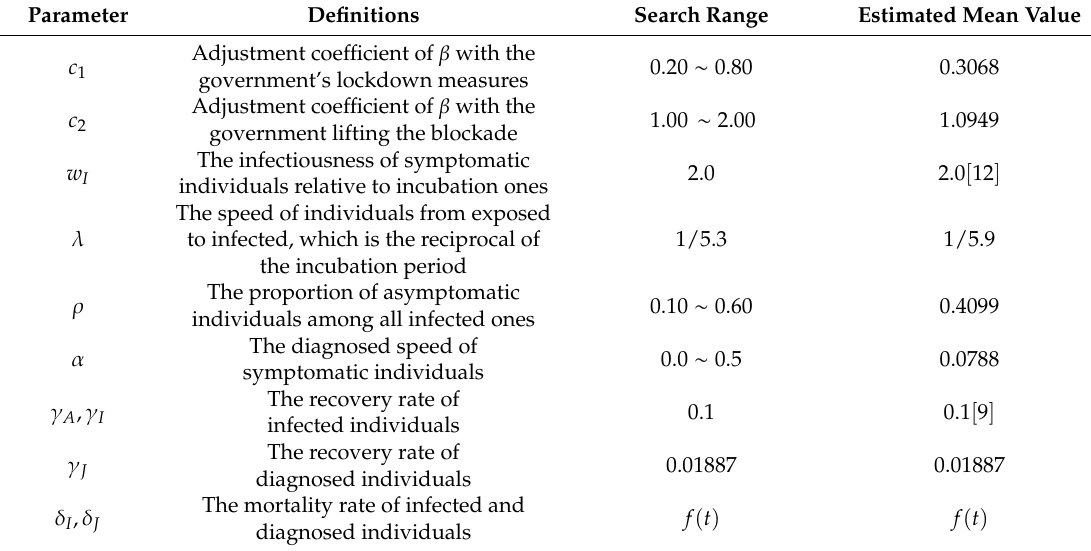
Table 1. SEIR_QJD parameter setting (Italy). Table 1. Cont.